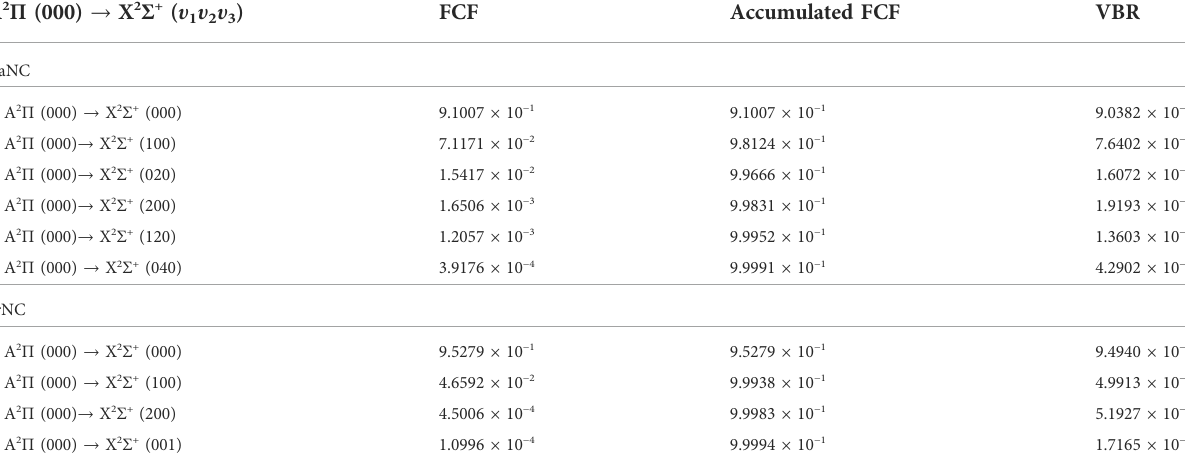
TABLE 3 The calculated Franck-Condon factors (FCFs) and vibrational branching ratios (VBRs) of the A 2 Π (000) → X 2 Σ + ( υ 1 υ 2 υ 3 ) transitions for CaNC and